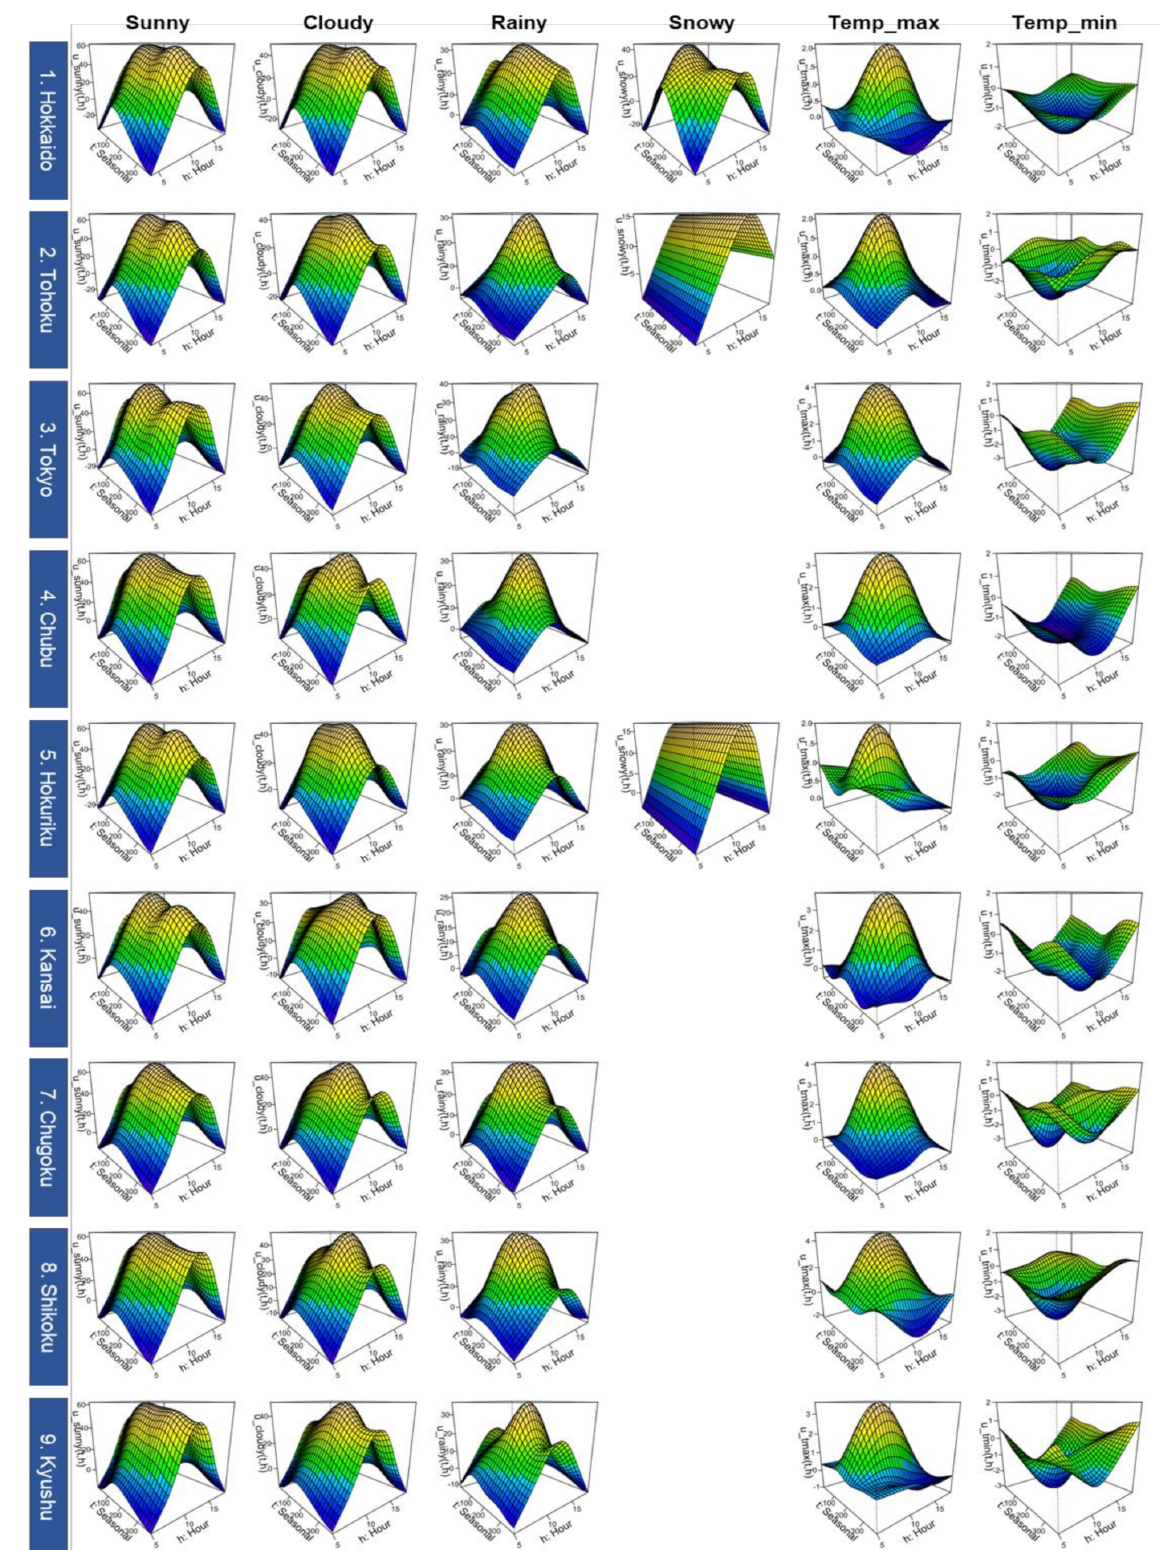
Figure A1. Estimated trends for areawide PV power generation model (all nine areas). Note: The unit of vertical axis for “Sunny,” “Cloudy,” “Rainy” and “Snowy” is (%), and that for “Temp_max” and “Temp_min” is (%/ ◦ C). “Seasonal” denotes a yearly cyclical dummy variable (see Section 2.1), and “Hour” denotes the time